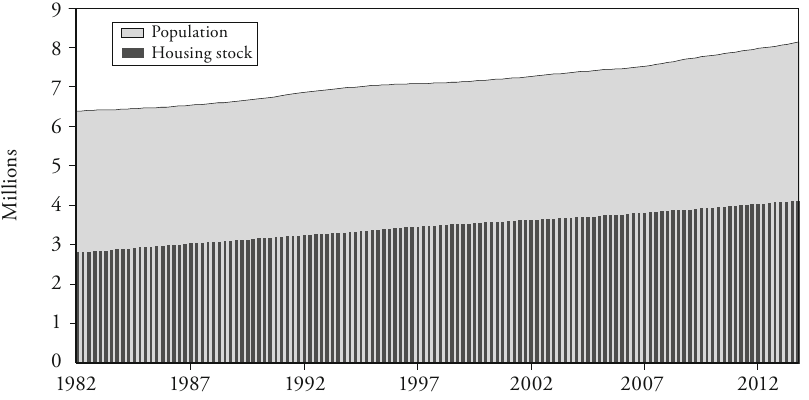
Figure 2: Swiss Population and Housing Stock Level